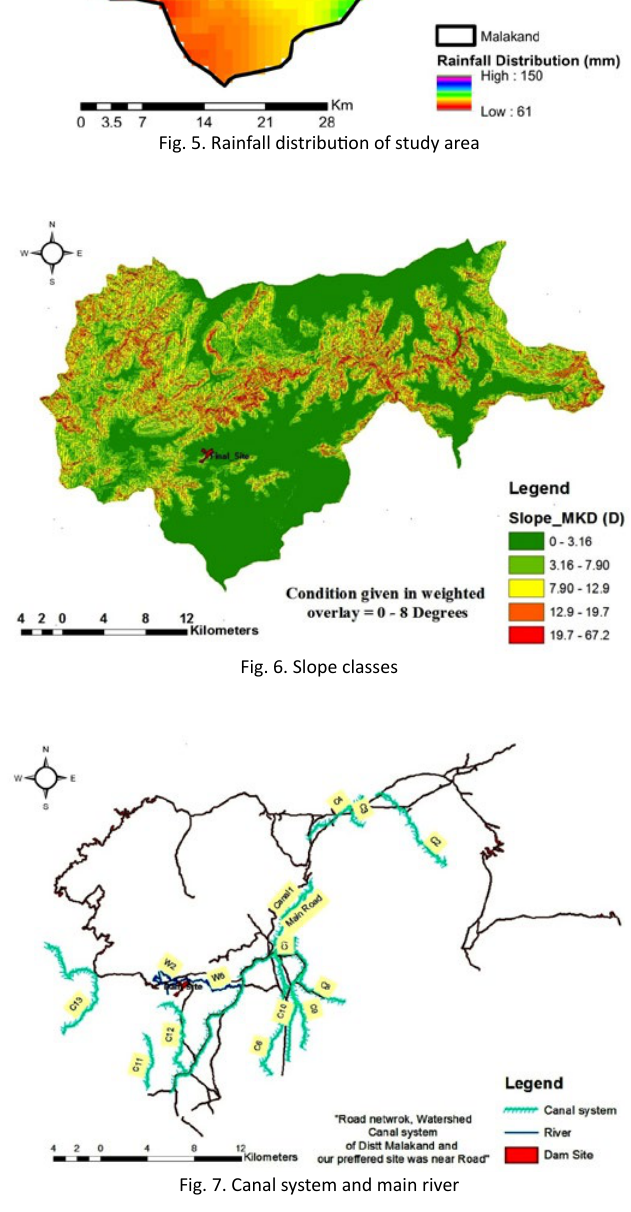
Fig. 7. Canal system and main Fig. 7: Canal system and main river